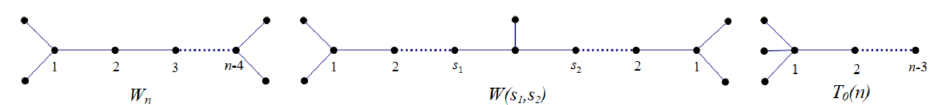
Figure 2. Graphs W n , W ( s 1 , s 2 ) and T 0 ( n )